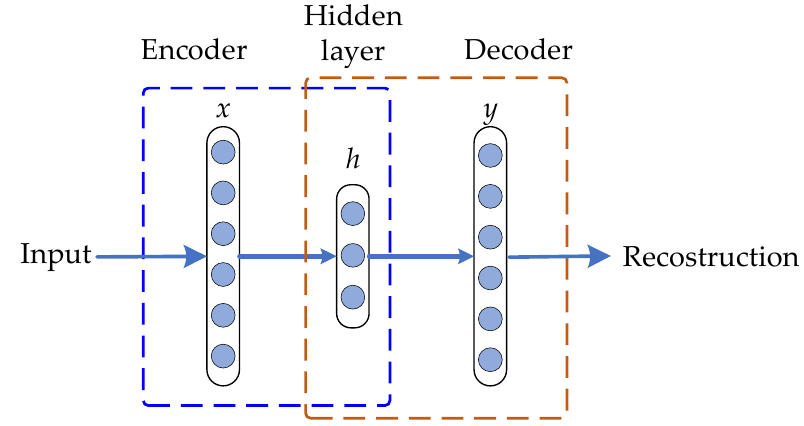
Figure 1. Graphical representation of the structure of a single-layer autoencoder.